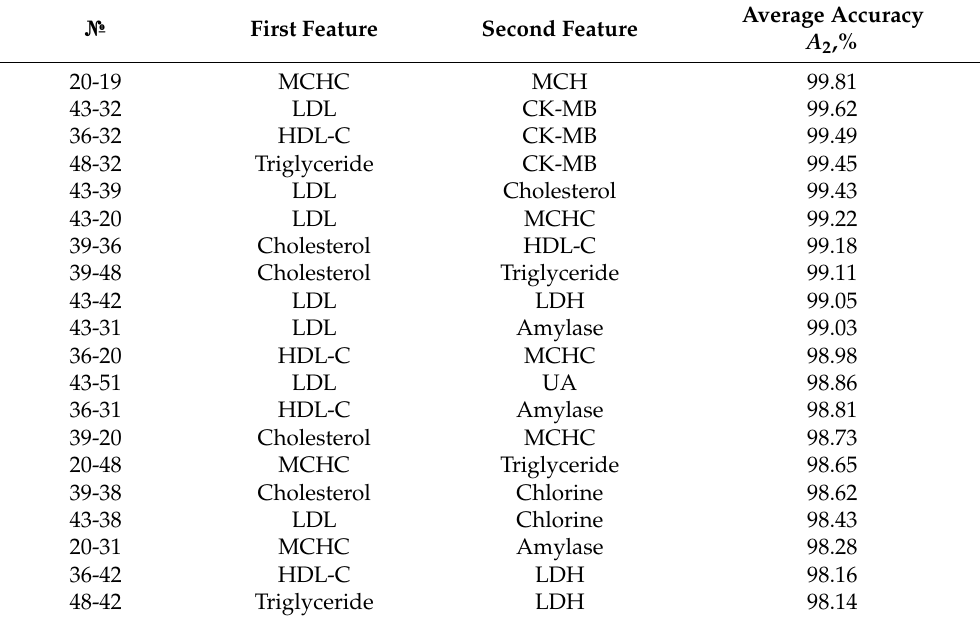
Table 7. Classification efficiency of SARS-CoV-2-RBV1 dataset using 2 features for the Histogram- based Gradient Boosting classifier.